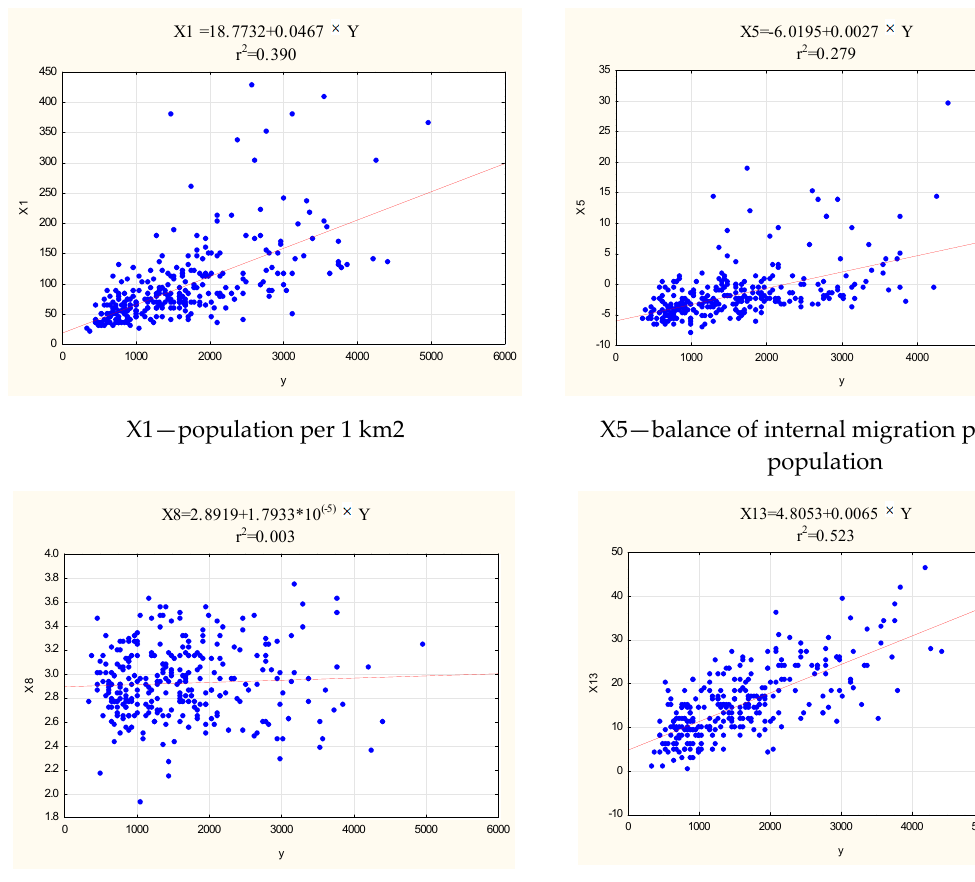
Figure 10. Dependency/relationship between the classification of areas (summary synthetic index WO) and epidemiological risk (number of cases) (COVID-19) — pandemic wave (30 November 2020). Source: own elaboration.